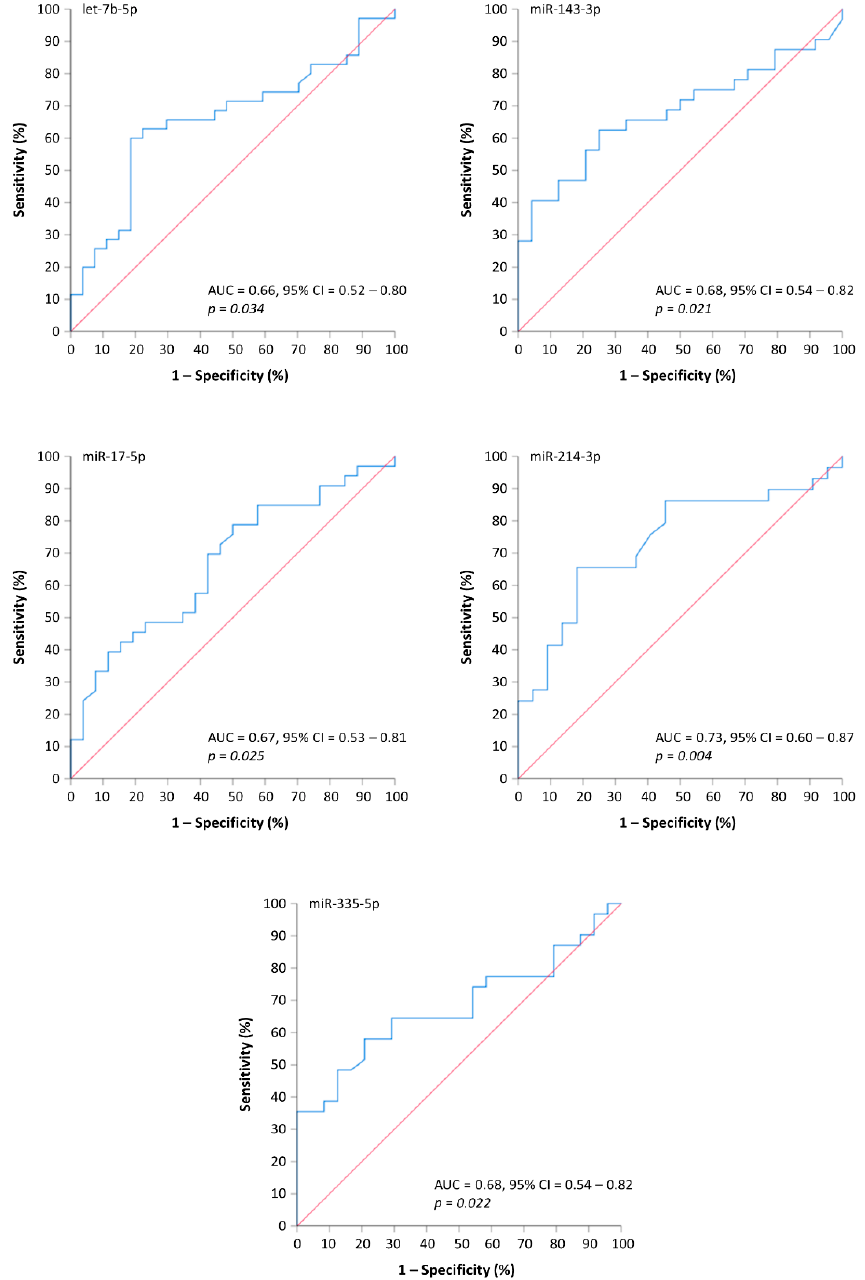
Figure 2. Receiver operating characteristic (ROC) curves based on let-7b-5p, miR-143-3p, miR-17-5p, miR-214-3p, and miR-335-5p levels in plasma. All miRNAs can distinguish MM patients with MMBD from those without MMBD.